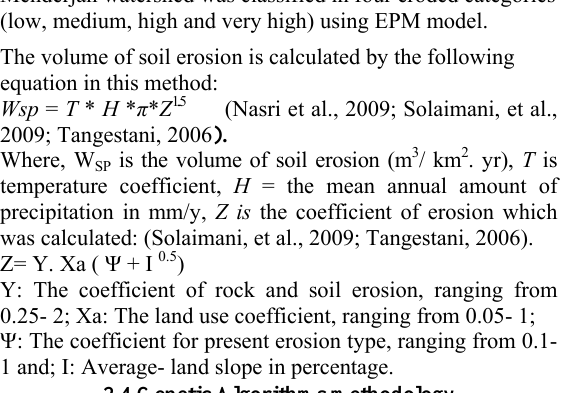
Figure 2: Location of study